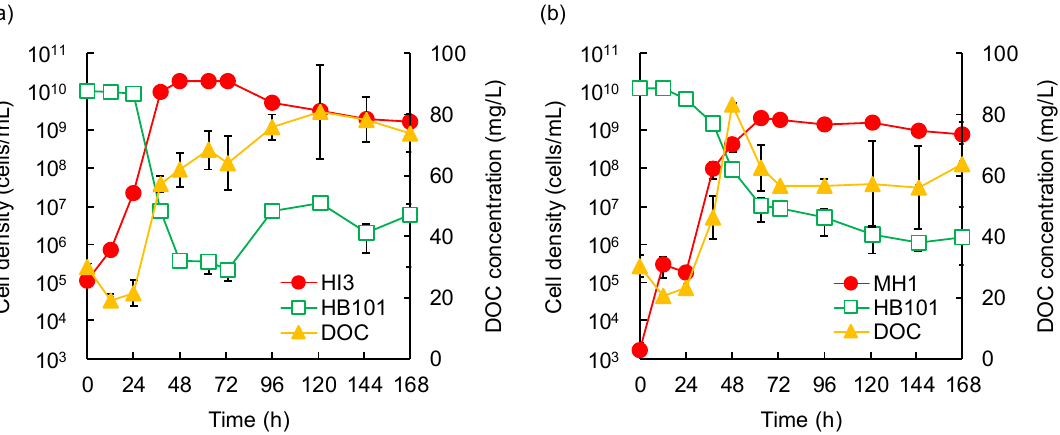
Figure 3. Temporal changes in predator and prey cell densities and dissolved organic carbon (DOC) concentration, during co-cultivation of Bacteriovorax stolpii HI3 ( a ) or Myxococcus sp. MH1 ( b ) as predator, with Escherichia coli HB101 as prey. Error bars represent standard deviation ( n = 3). In the co-culture of HI3 and HB101, the cell density of HB101 remained stable